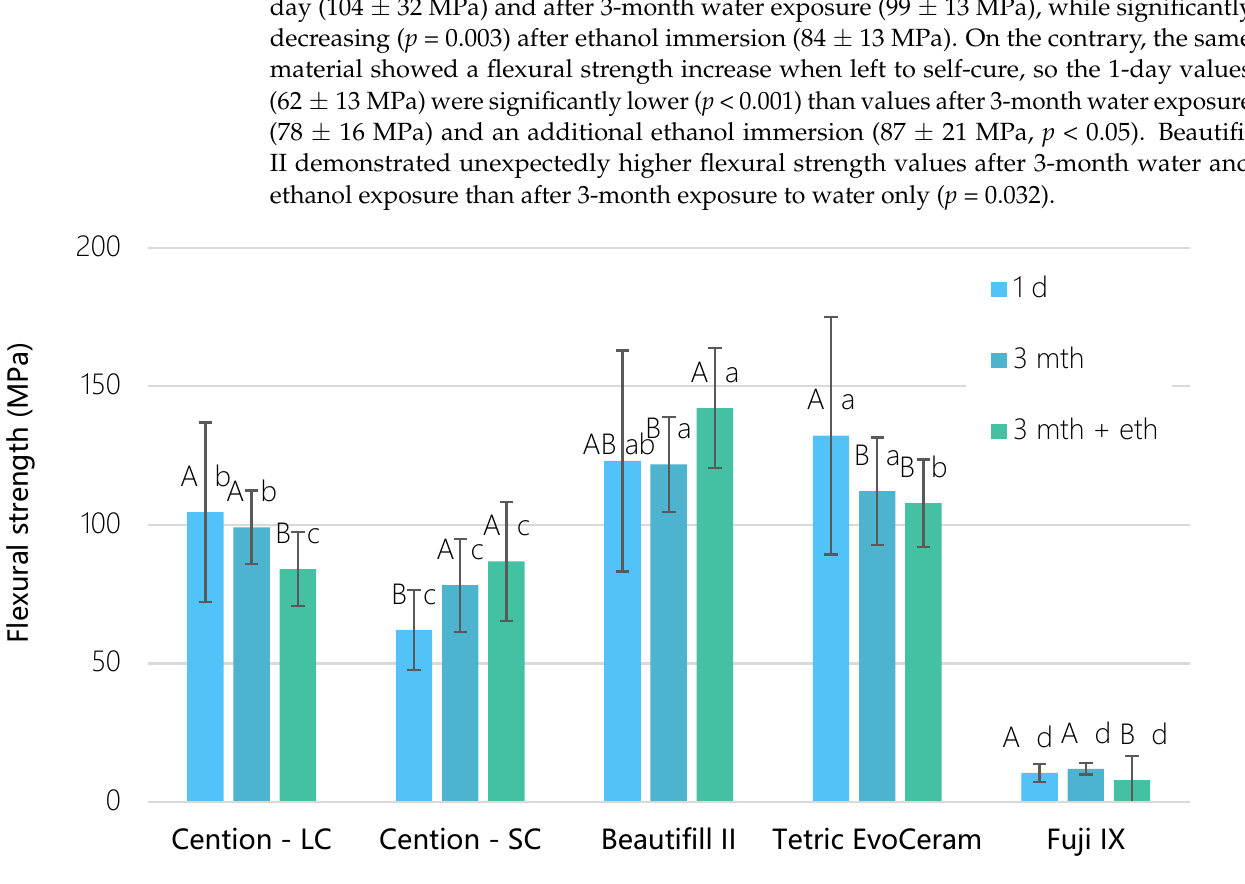
Figure 2. Flexural strength as a function of time for tested materials (mean values ± standard deviation, n = 20). Identical uppercase letters denote p > 0.05 for the same material between different time points; identical lowercase letters denote p > 0.05 between materials at the same time point.